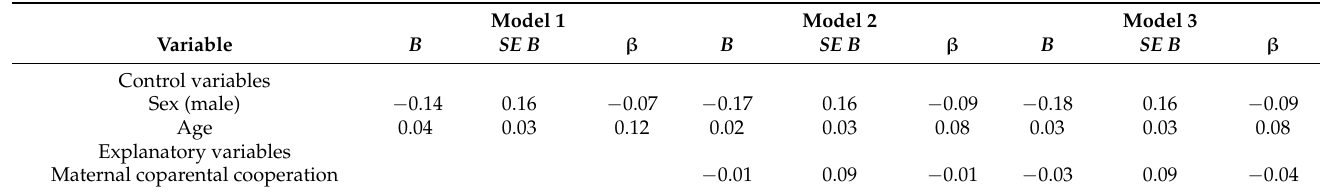
Table 4. Summary of hierarchical multiple regression for some variables related to the parental divorce process predicting attachment-related